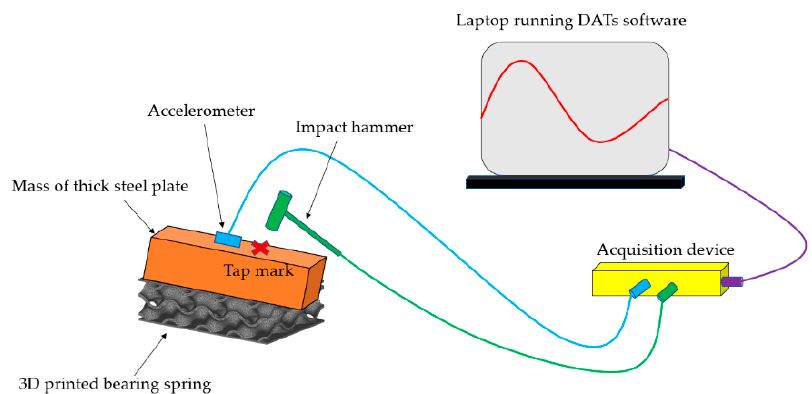
Figure 8. Record data employing the tap hammer and the acquisition device.